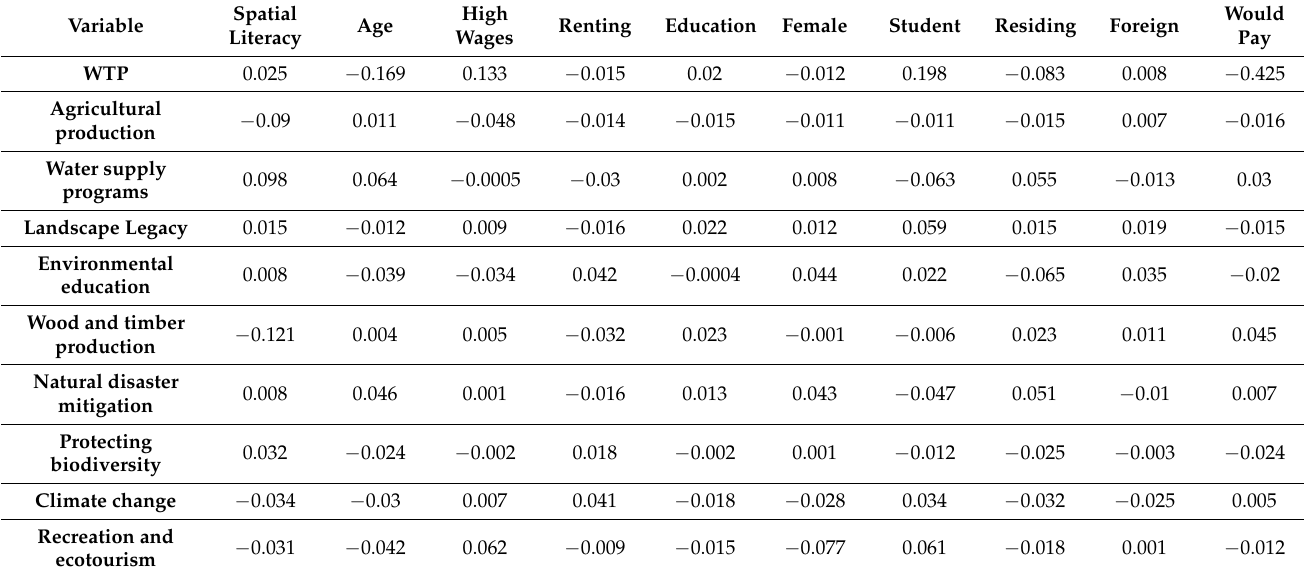
Table A2. Correlation coefficients between explanatory variables (columns) and variables of interest (rows). This includes willingness to pay (WTP; row 1), as well as the quantitative values reported as answers to the questions featured in Table 1.